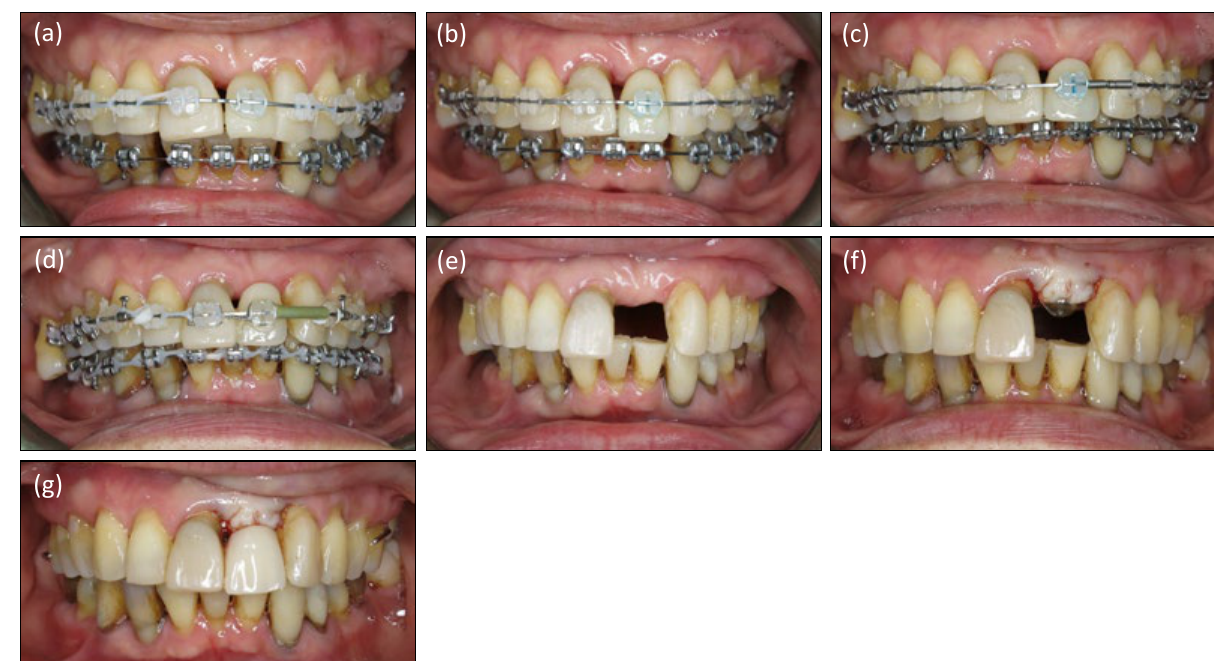
Figure 7. Frontal photographs of treatment progress at various time-points: (a) three months, (b) five months, (c) eight months, (d) 14 months, (e) 19 months, (f) 23 months – following stage 2 implant surgery, (g) 23 months – with immediate removable acrylic partial denture in place.